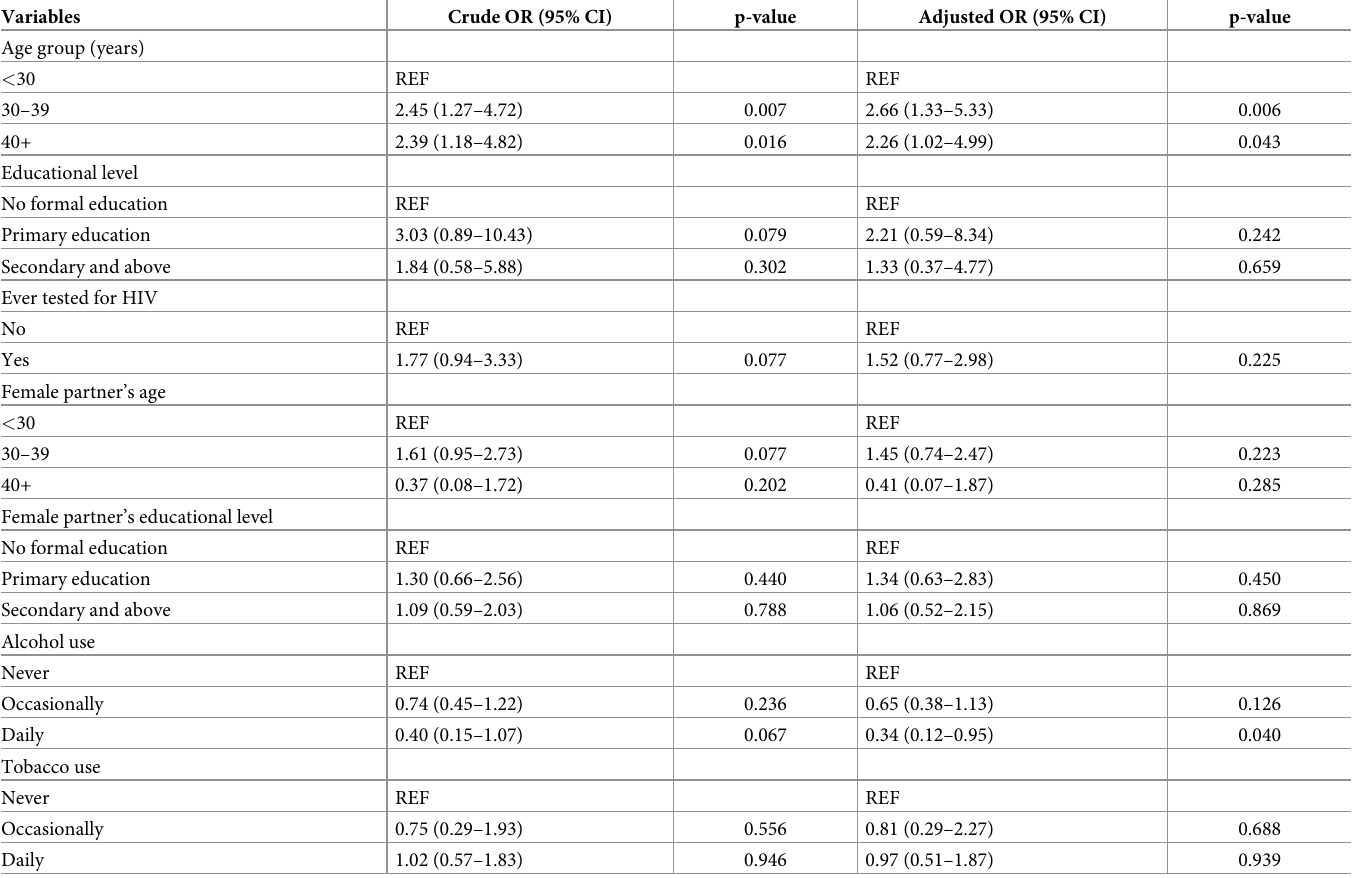
Table 4. Simple and multivariable logistic regression analyses of factors associated with HIV positivity among male partners of HIV-positive pregnant females in Benue State, Nigeria (n =